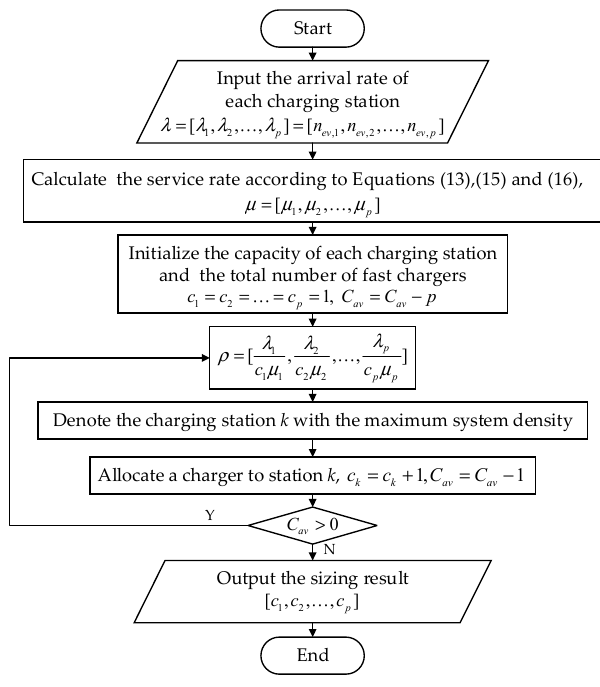
Figure 11. The flowchart of sizing with the hybrid method.